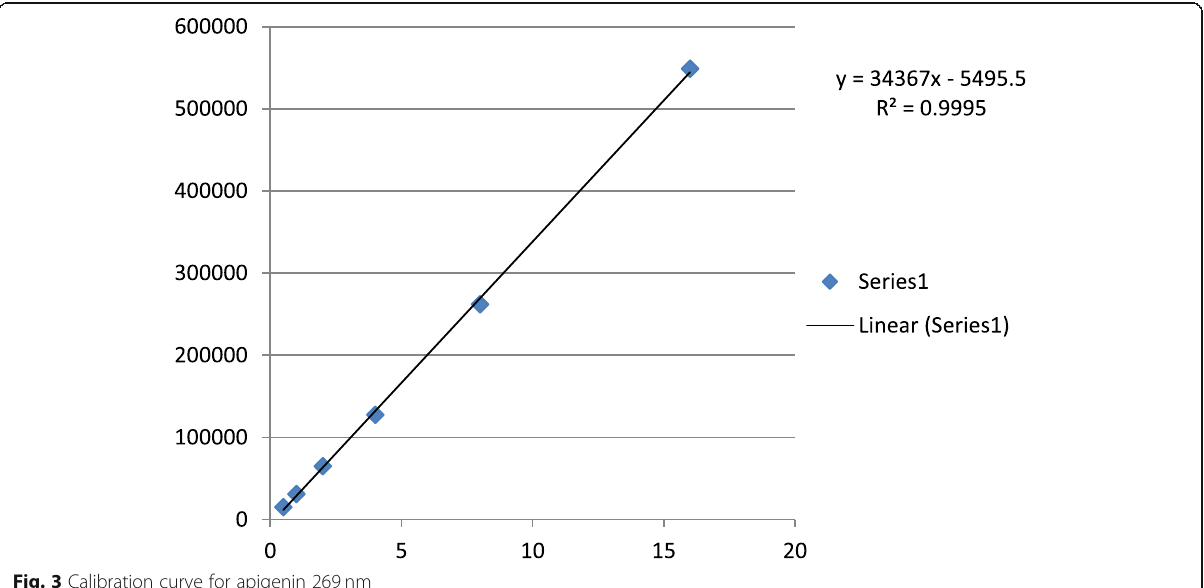
Fig. 3 Calibration curve for apigenin 269 nm